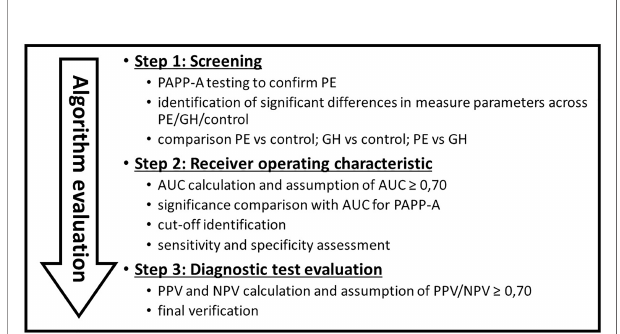
FIGURE 1 | Study fl ow diagram. Criteria for test selection.